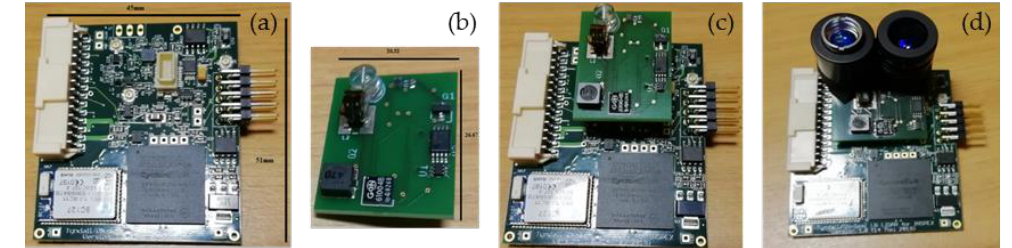
Figure 8. Optimized long-range LiDAR Components: ( a ) Motherboard; ( b ) Optics board; ( c ) Module; ( d ) Module with Optics.